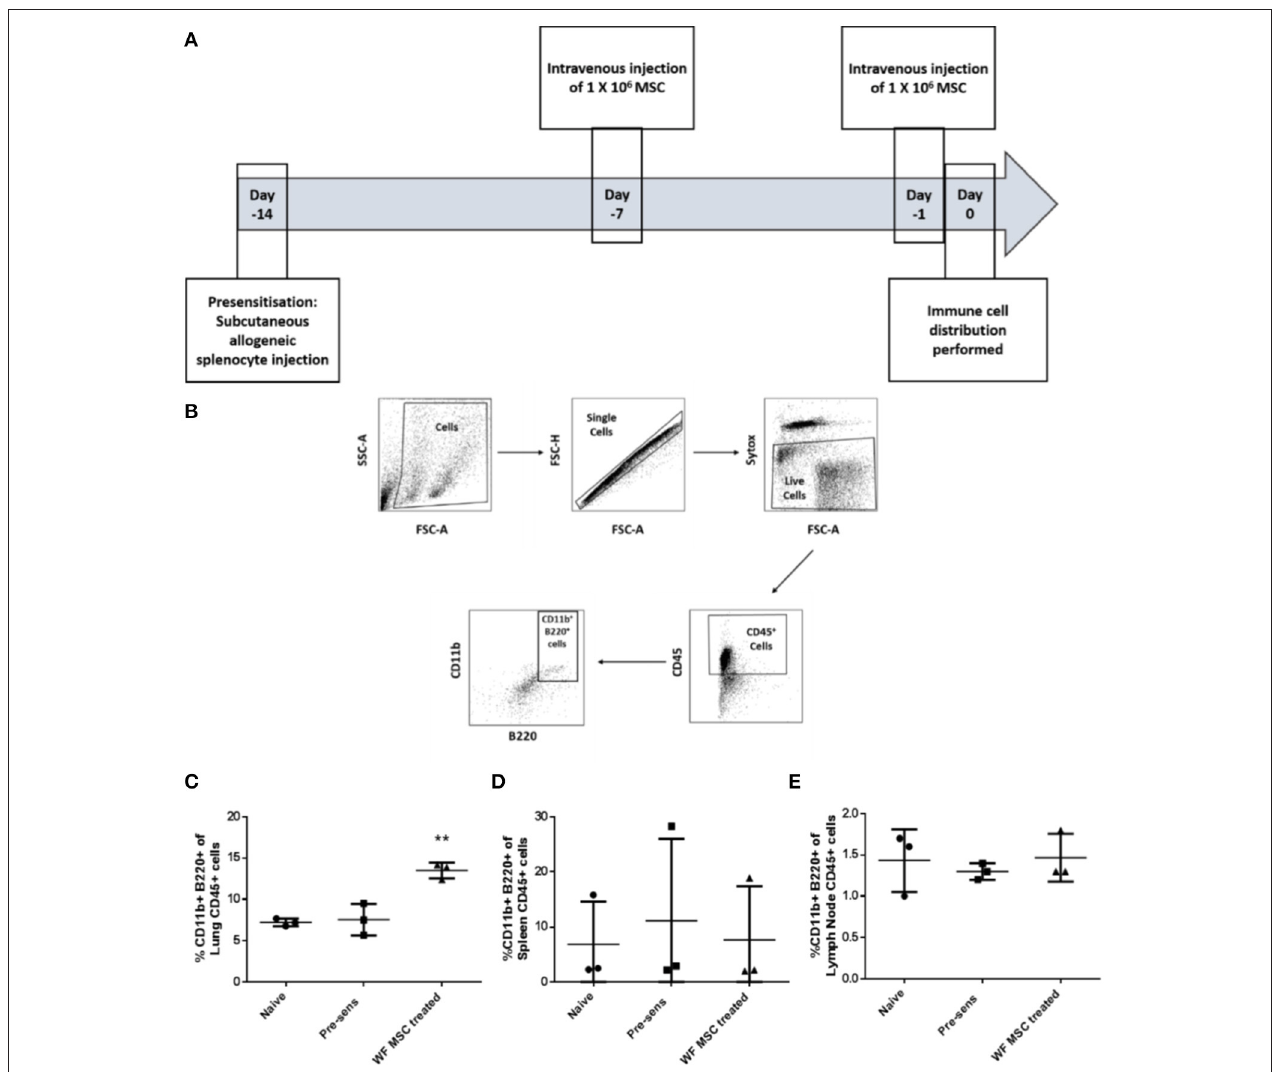
FIGURE 3 | Third-party allo-MSC administration to pre-sensitized Lewis rats results in a proportionate increase in lung CD11b + /B220 + cells on the day of transplantation. (A) Schematic representation of experiment to evaluate immune cell profiles in pre-sensitized Lewis rats treated with third-party allo-MSC 1 and 7 days earlier . (B) Gating strategy used to gate CD11b + B220 + cells from tissues of transplanted rats (C–E) Graphs showing results of flow cytometry analysis of the proportion of CD45 + cells co-expressing CD11b and B220 in the lungs (C), spleens (D) and submandibular lymph nodes (E) of non-pre-sensitized/untreated rats (naïve, n = 3); pre-sensitized/untreated rats (Pre-sens, n = 3) and pre-sensitized/third-party allo-MSC treated rats (WF MSC treated, n = 3). Results for individual animals (symbols) and mean ± SEM for each group (horizontal lines with error bars) are shown. Statistical analysis was performed using one-way ANOVA with Tukey’s post-test, ** p <